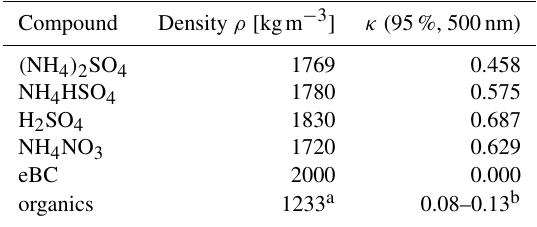
Table 1. κ values and densities for pure compounds used for the prediction of aerosol hygroscopicity based on AMS and aethalome- ter or MAAP